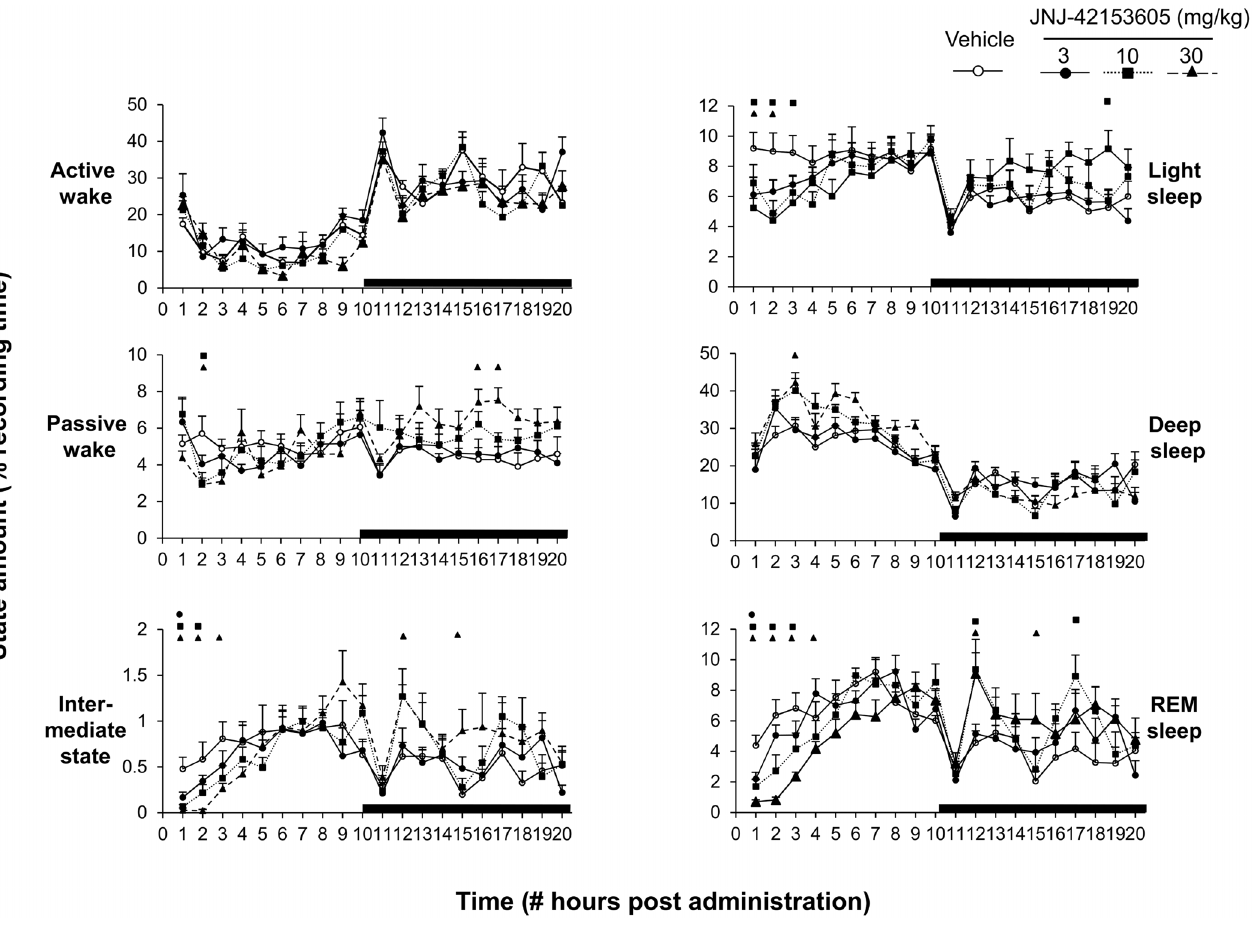
Fig 5. Percentage distribution of the vigilance states active wake, passive wake, intermediate stage, light sleep, deep sleep and rapid eye movement (REM) sleep for each hour period of the 20-h recording session following acute JNJ-42153605 (3, 10, 30 mg/kg) or vehicle. Open and dark areas in the abscissa axis indicate light and dark phase of the circadian time, respectively. Values are presented as means ± S.E.M. for each condition expressed in percentage of the recording time. Each symbol indicates statistically significant difference (P < 0.05) between vehicle and drug-dose injected